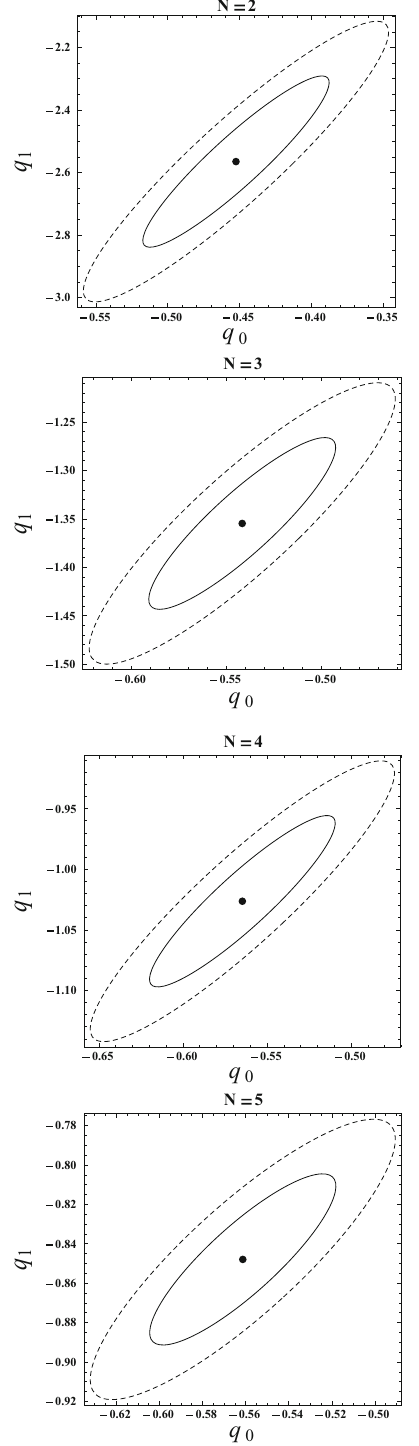
Fig. 1 1 σ ( solid line ) and 2 σ ( dashed line ) confidence level contours in ( q 0 , q 1 ) plane have been shown for different choices of N . In each panel , the large dot indicates the best-fit values of q 0 and q 1 arising from the analysis of SNIa + BAO/CMB dataset